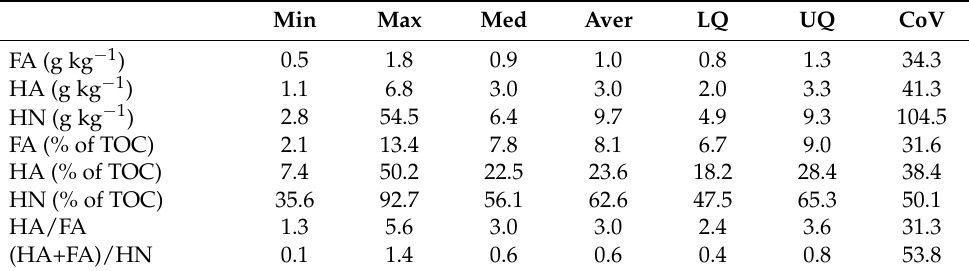
Table 2. Humic substances content in soils (n =